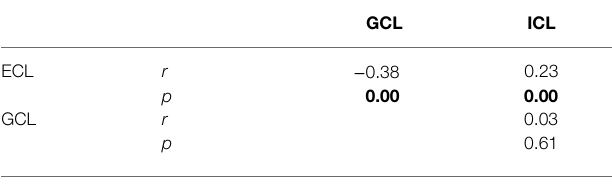
TABLE 3 | Parallel-test reliability via Pearson-correlations ( n =